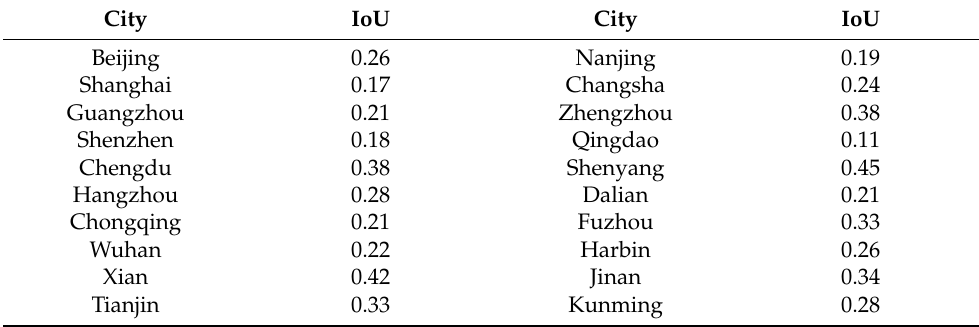
Table A2. The intersection over union (IoU) metrics between two types of hotspots among 20